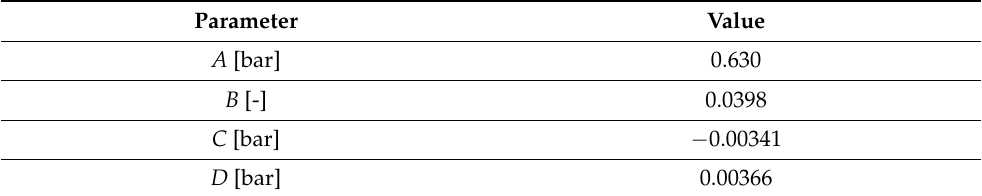
Table 1. Parameters determined for the Chen–Flynn FMEP model.